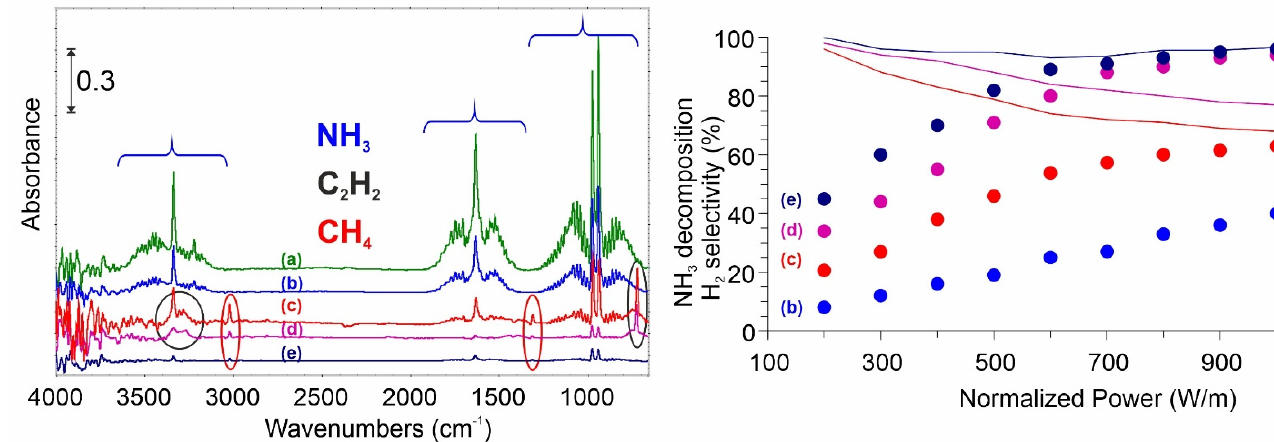
Figure 2. Left panel: FTIR spectra of the gas phase before (a) and after the NH 3 splitting process over tested carbons: (b) no catalyst, (c) C ox , (d) C des , (e) C des N. Right panel: catalytic conversion and selectivity of tested systems.